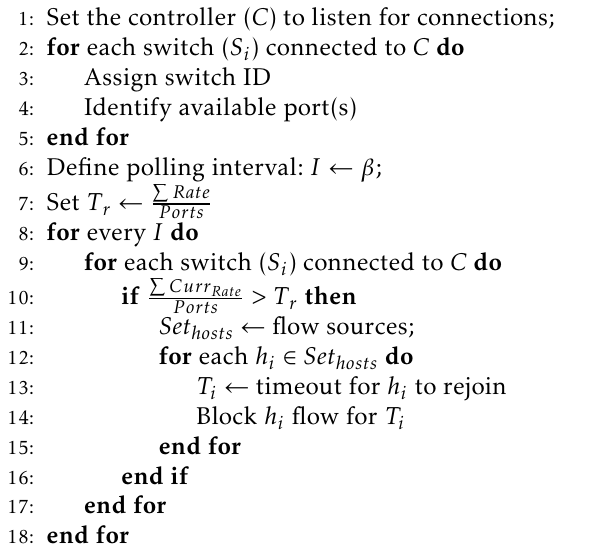
Algorithm 1 SDM: Software Defined networking DoS Mitigation